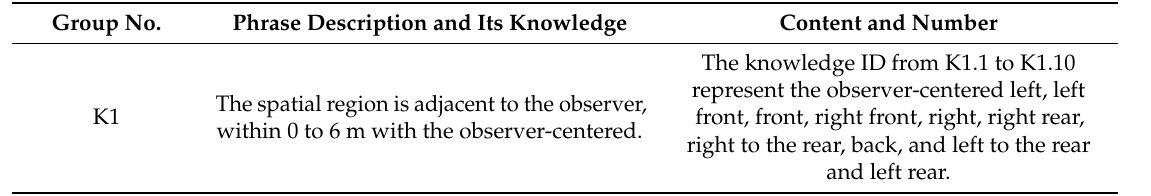
Table 1. Observer’s spatial knowledge set